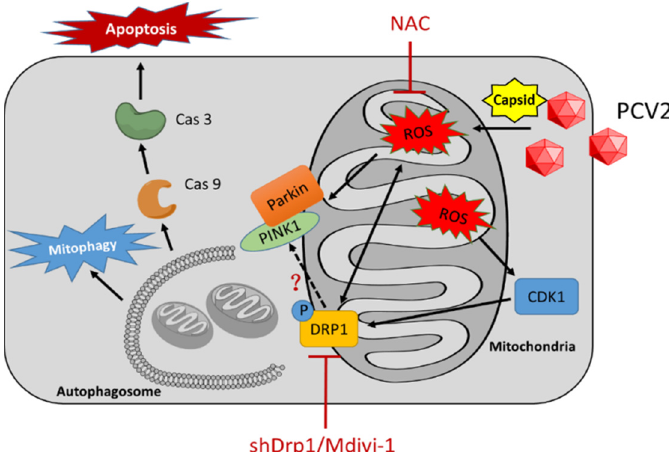
Figure 9. A proposed model of mitophagy and mitochondrial apoptosis induced by PCV2 infection. PCV2 infection induces oxidative stress, loss of mitochondrial mass, and mitochondrial membrane potential, probably through its capsid protein [4], leading to mitochondrial fission, mitophagy, and mitochondrial apoptosis. ROS induced by PCV2 infection stimulates Drp1 phosphorylation, probably by activating its upstream molecule CDK1. N-acetyl-L-cysteine (NAC) treatment could reverse these PCV2-induced phenotypes, and inhibited Drp1 phosphorylation, PINK1 expression, and Parkin translocation to mitochondria. Inhibition of Drp1 via Mdivi-1 treatment or specific RNA silencing could reduce the amount of ROS and alleviate PCV2-induced mitophagy and mitochondrial apoptosis. PINK1 is another essential component of mitophagy, which is involved in Parkin’s translocation